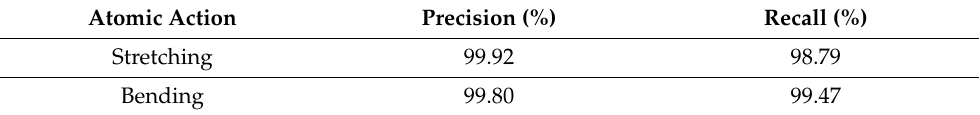
Table 1. Performance of the single-shot detector model (SSD) for test data.